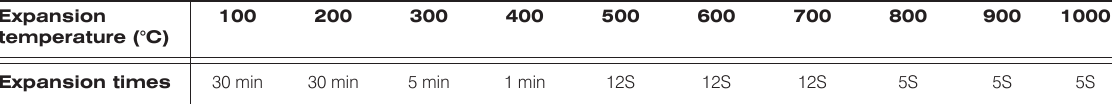
Table 2. Expansion times used corresponding to different expansion